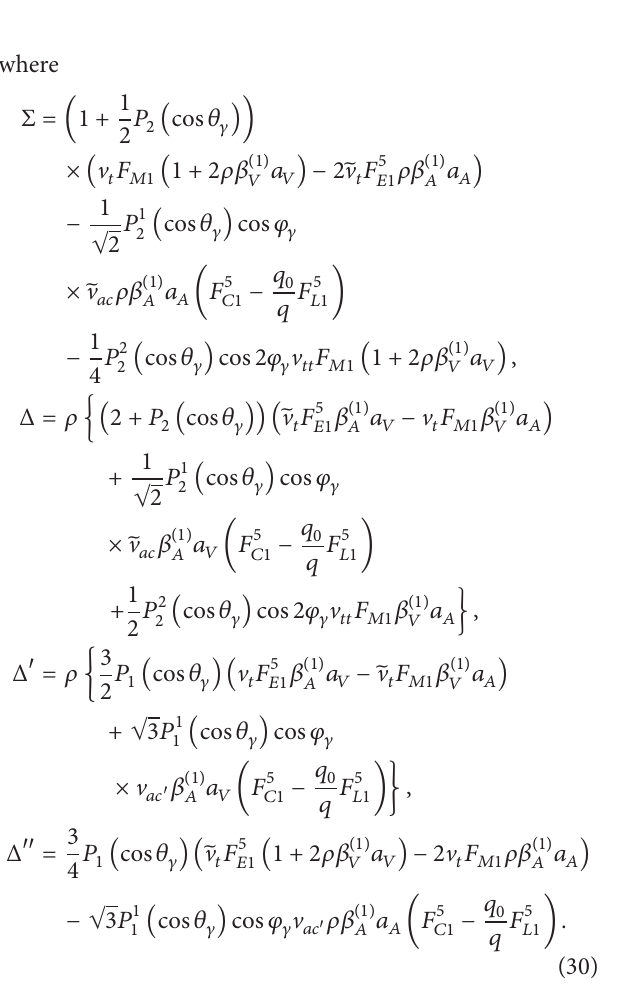
Figure 1: (a) Asymmetry coefficient for the electron. (b) Photon polarization